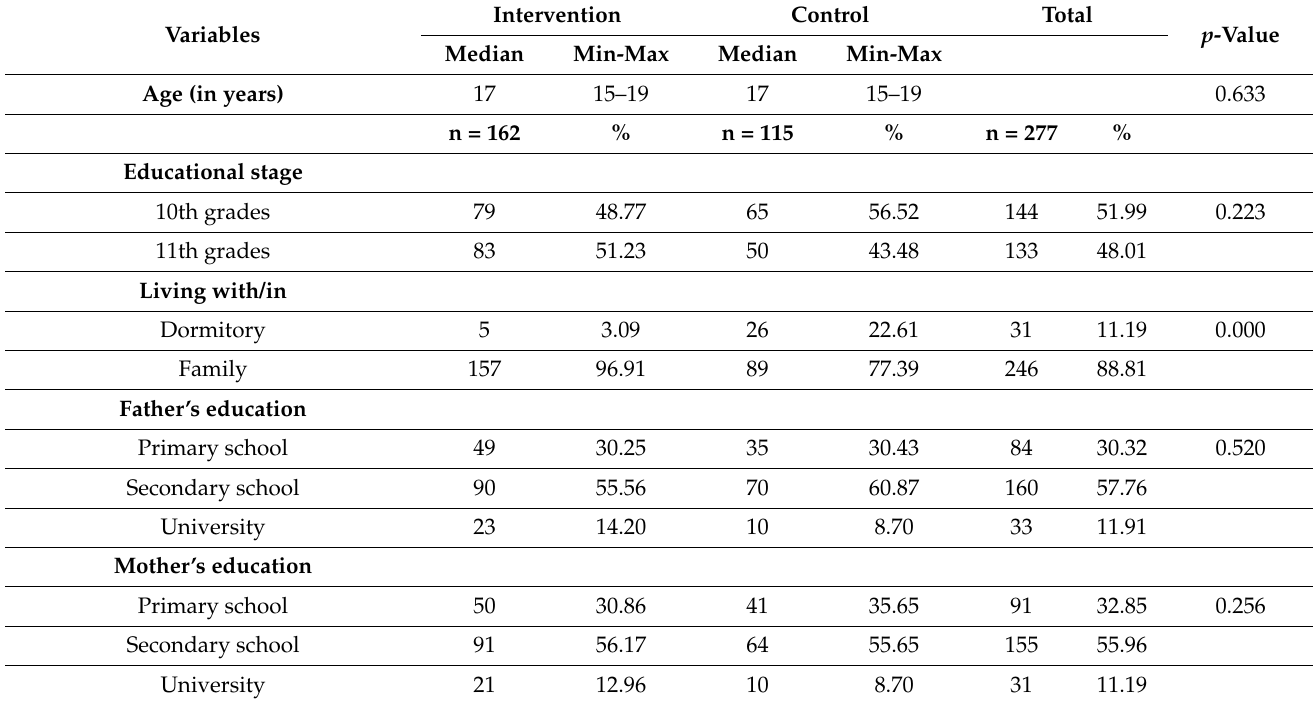
Table 1. Sociodemographic